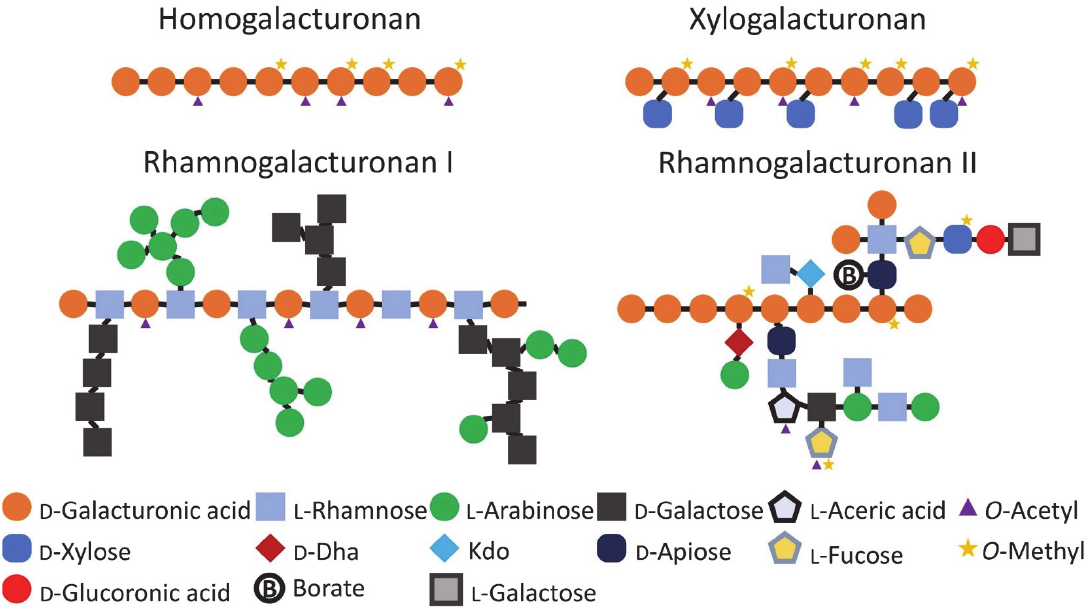
Figure 1. Schematic structural blocks of